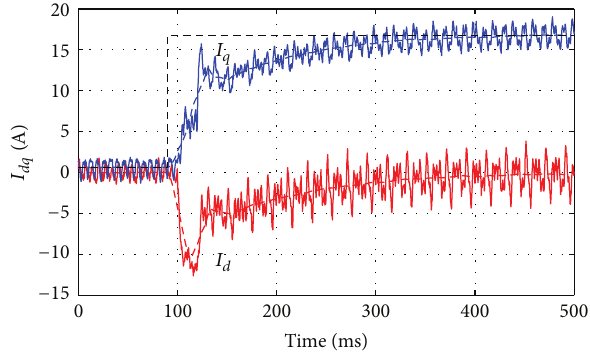
Figure 12: Step-up response in active power from 1kW to 21kW, 𝑄 ∗ = 0 .